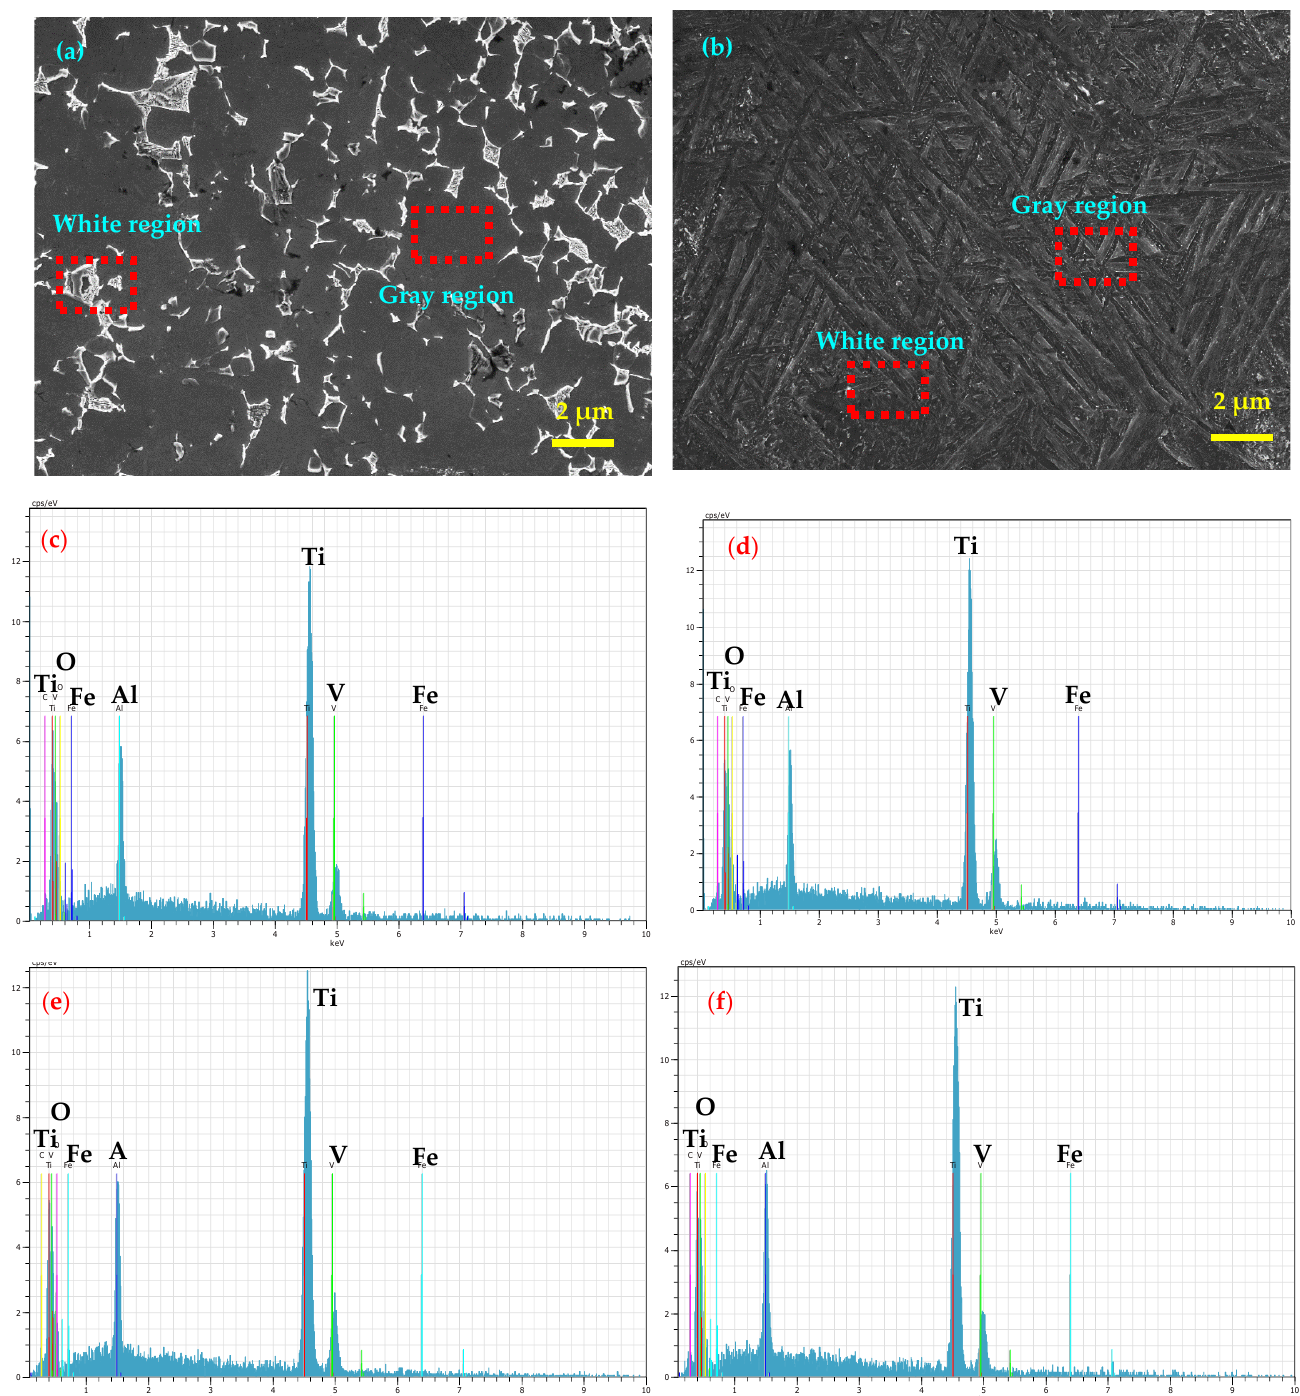
Figure 3. Micrograph of EDS analysis: ( a ) CACF specimen, ( b ) SLM specimen, ( c ) grey region of CACF specimen, ( d ) white region of CACF specimen, ( e ) grey region of SLM specimen, ( f ) white region of SLM specimen. Table 2. EDS analysis results of CACF and SLM specimens. EDS Analysis Results (In Atomic wt.%)